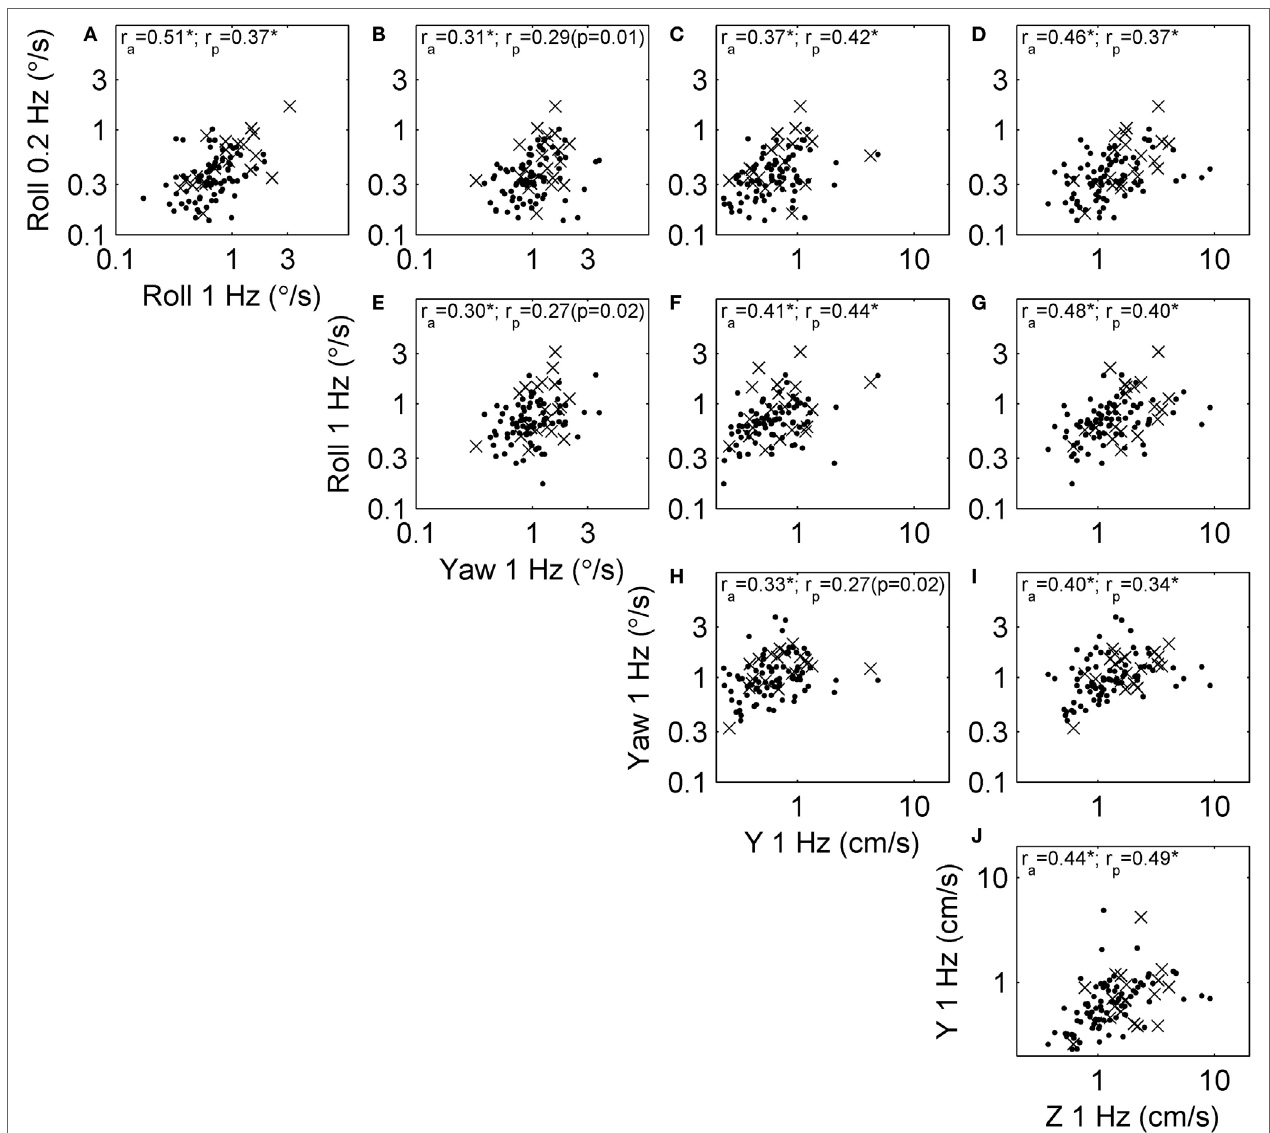
FigUre 4 | Scatterplots showing the relationship between each of the age-adjusted threshold measures across subjects. This repeats that analysis shown in Figure 3 in a way that focuses on correlation due to factors other than aging. Each subject is shown, and segmented into those who passed (dots) and failed ( × ) condition 4 of the balance test. Correlation coefficients were calculated using log-transformed, age-adjusted thresholds, including the correlation across all subjects ( r a ) and only those who passed condition 4 ( r p ). Most correlations were statistically significant at the p < 0.005 level (indicated by *), with exceptions noted by the actual p value. (a) The relationship between roll tilt 0.2 Hz thresholds and roll tilt 1 Hz thresholds across subjects. (B–J) The relationships between other corresponding pairs of